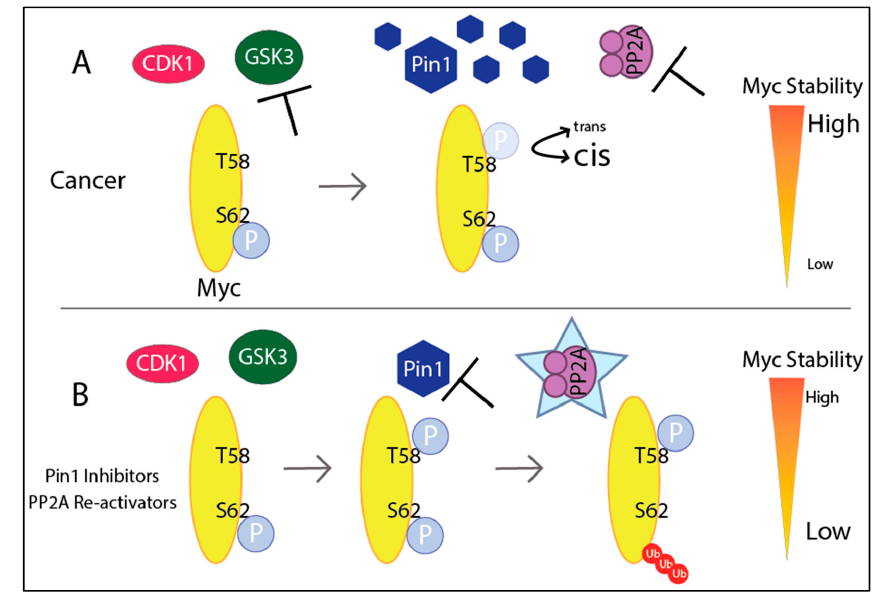
Figure 5. Disrupting Myc stability: ( A ) In cancer, PI3K signaling inactivates GSK3, preventing phosphorylation of T58 Myc. Pin1 overexpression keeps Myc in the cis -confirmation, preventing PP2A trans -specific enzyme from binding to Myc. Furthermore, PP2A is inactivated in several cancers, and therefore S62 remains phosphorylated. All of this leads to high Myc stability. ( B ) Inhibition of PI3K allows for GSK3 to phosphorylate T58 on Myc, which is required for degradation. Pin1 inhibitors and PP2A activators allow for PP2A to recognize and remove the phosphorylation of S62, leading to low stability and Myc’s